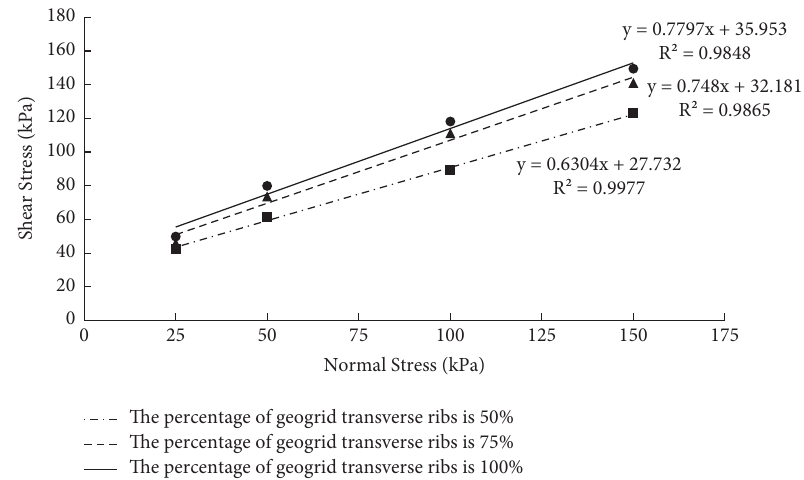
Figure 18: Fitting curve of shear strength under diferent percentages of geogrid transverse ribs.